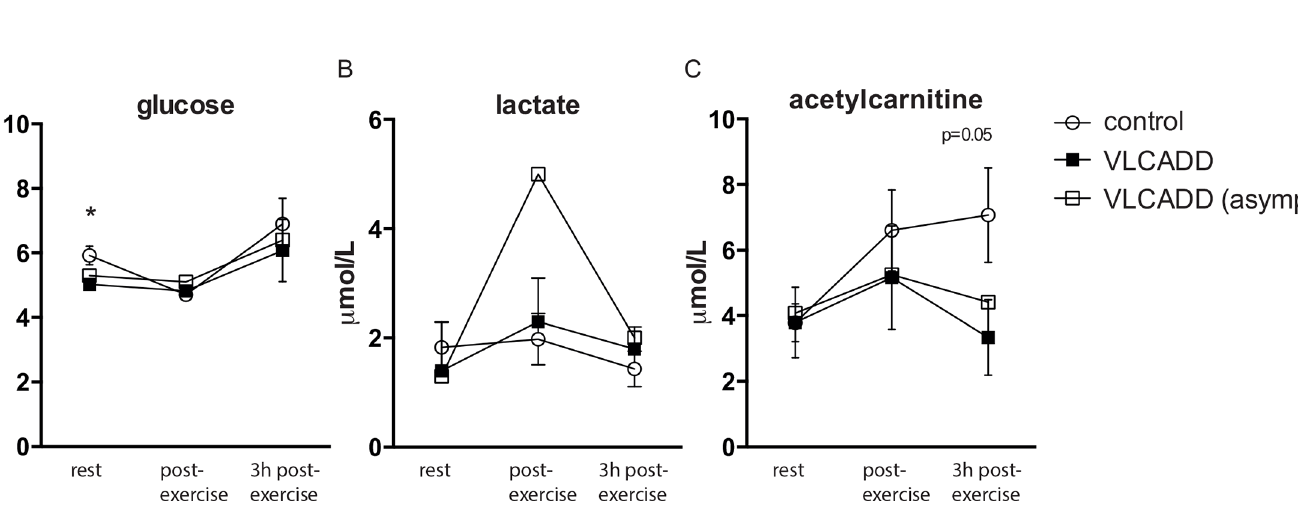
Fig 1. (A) Maximal workload of symptomatic (black squares) and asymptomatic (open squares) VLCADD patients and controls. (B) in symptomatic (black squares) and asymptomatic (open squares) VLCADD patients. (C) Fatty acid oxidation in mg/kg body mass/min in VLCADD patients and controls. Error bars indicate ± SEM. * P < 0.05 for polynominal curve.